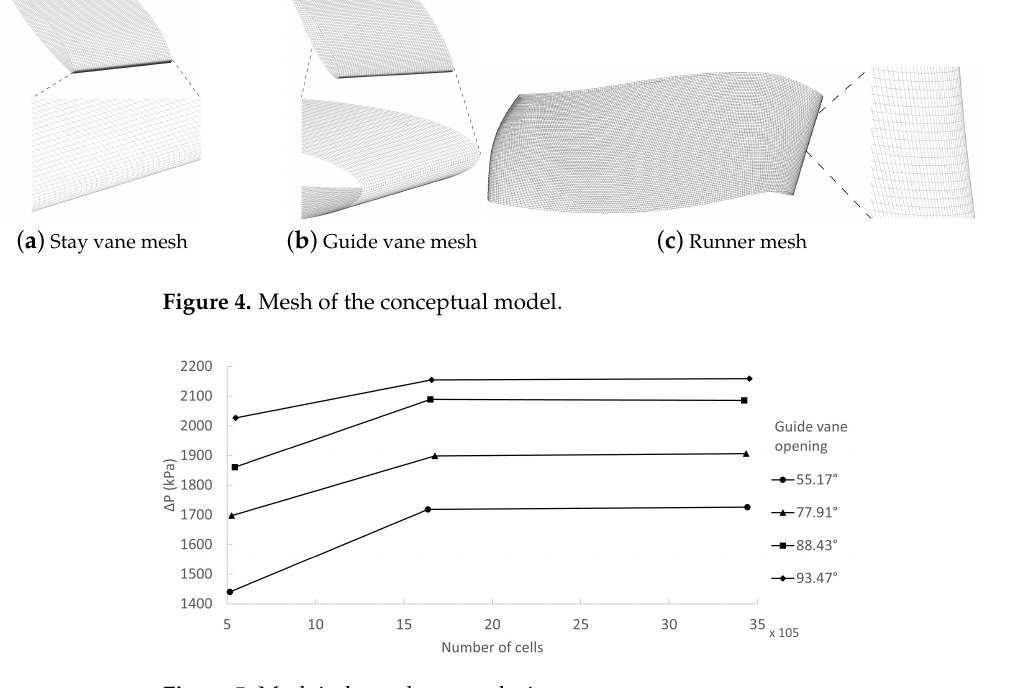
Figure 5. Mesh independence